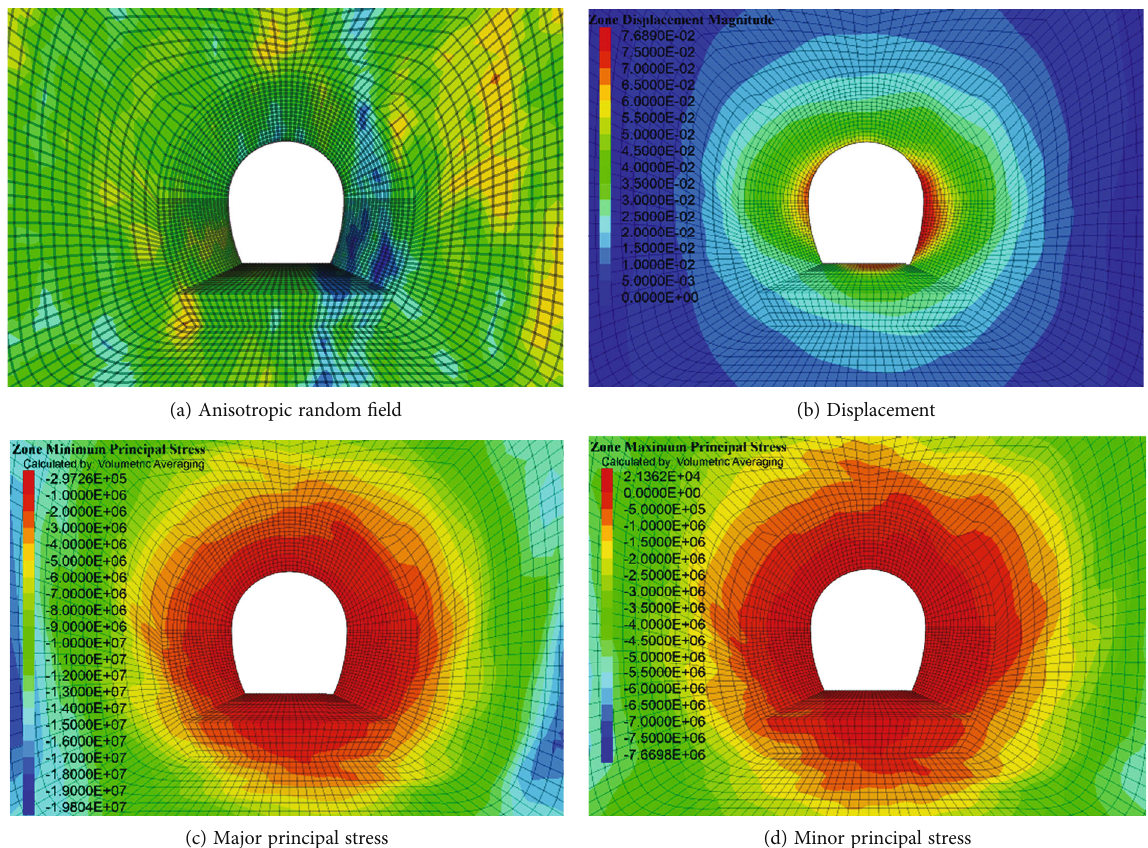
Figure 15: Analysis of cavern excavation results with 90 ° anisotropic fi